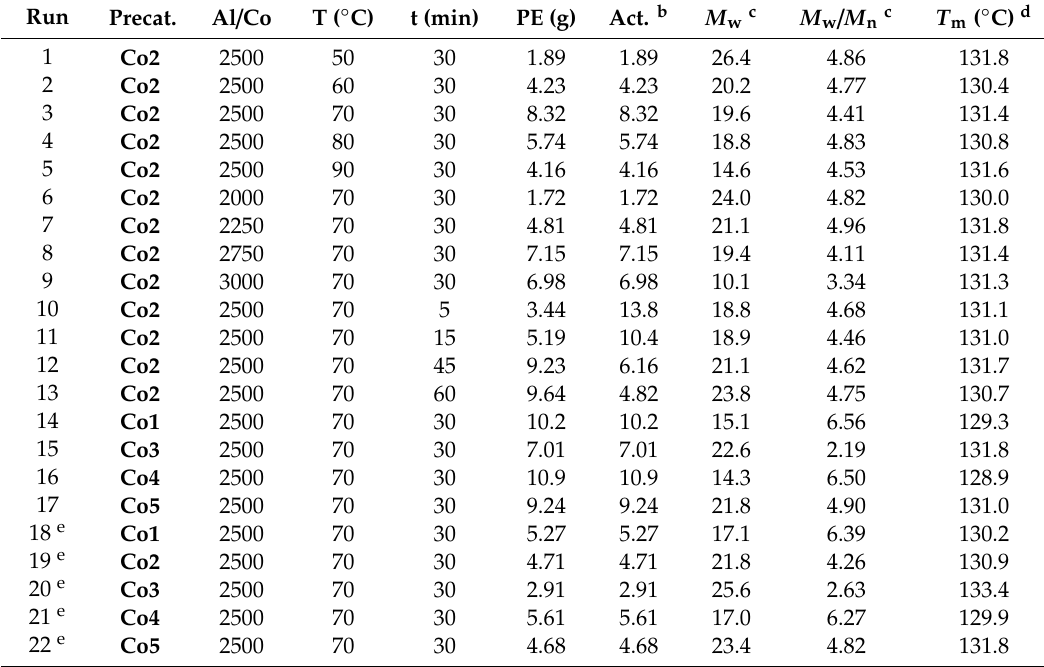
Table 2. Polymerization screening using Co1 – Co5 a